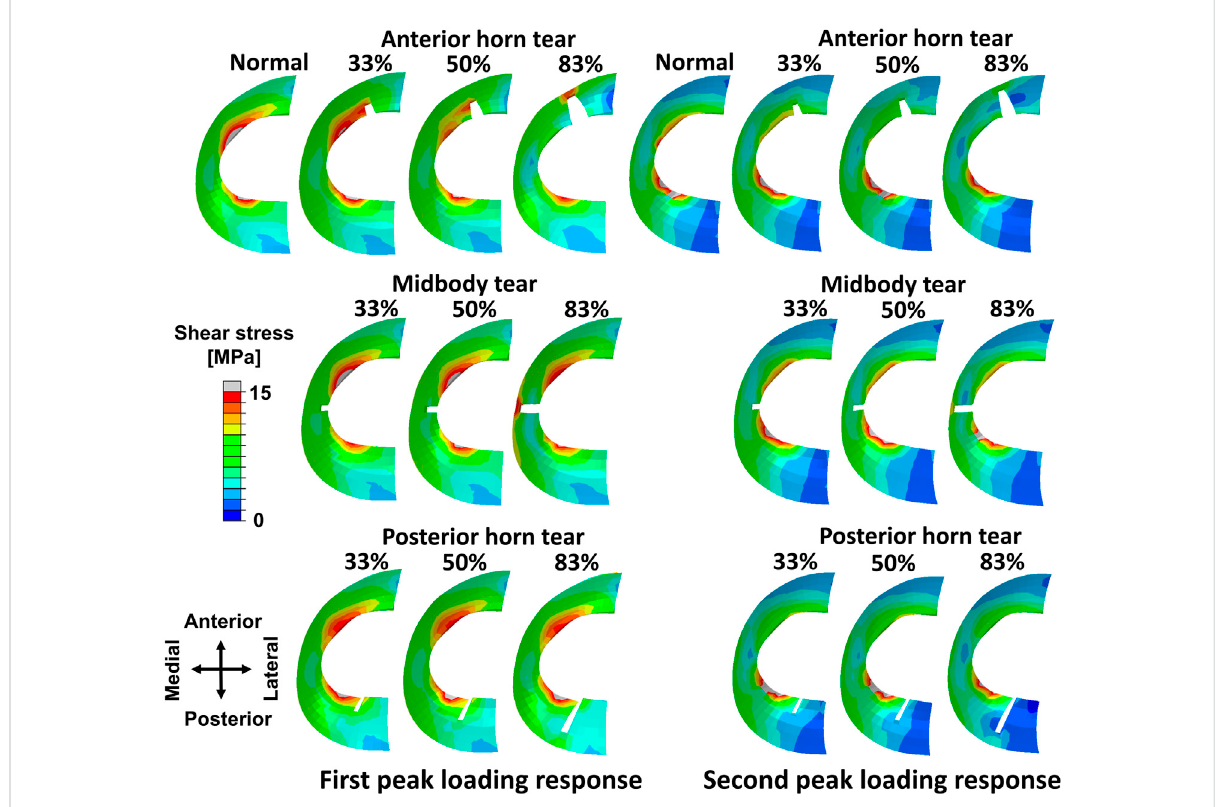
FIGURE 3 Results of shear stress distribution on the medial meniscus involving a healthy knee and a knee with radial tears in the medial meniscus during the maximum weight acceptance and